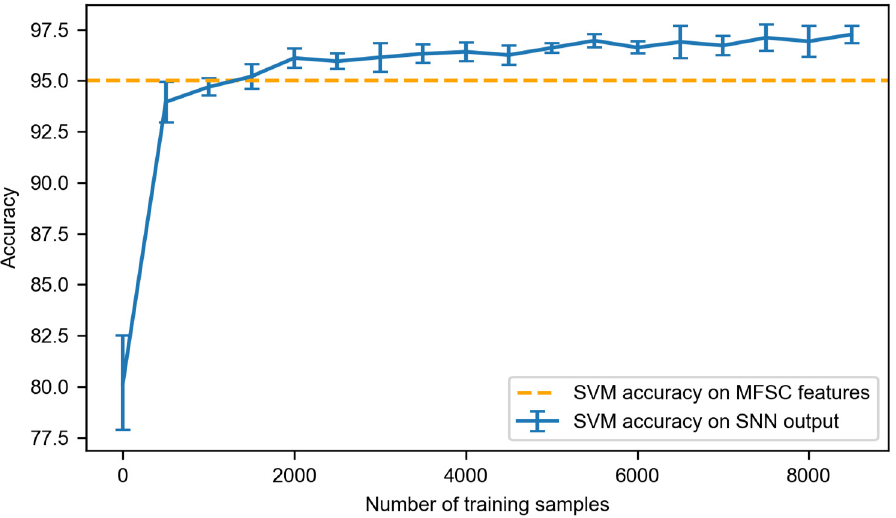
Fig 5. The SVM classification accuracy curve on the test set averaged over five runs. The SVM accuracy on the SNN output exceeded the accuracy on the MFSC features after 900 samples. The accuracy converges to about 97.5% after 6000